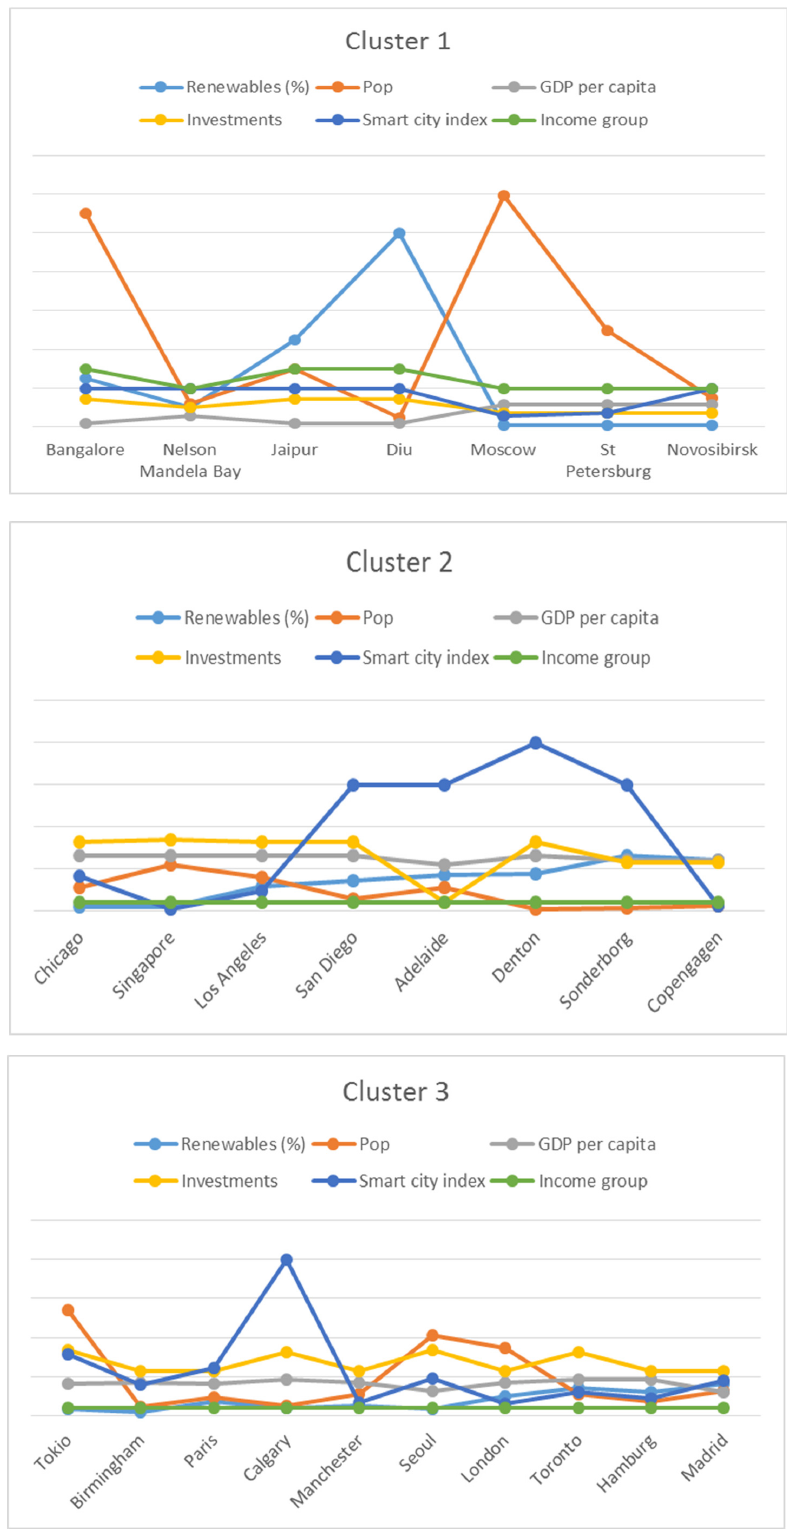
Figure 3. Comparison of results of cluster analysis.